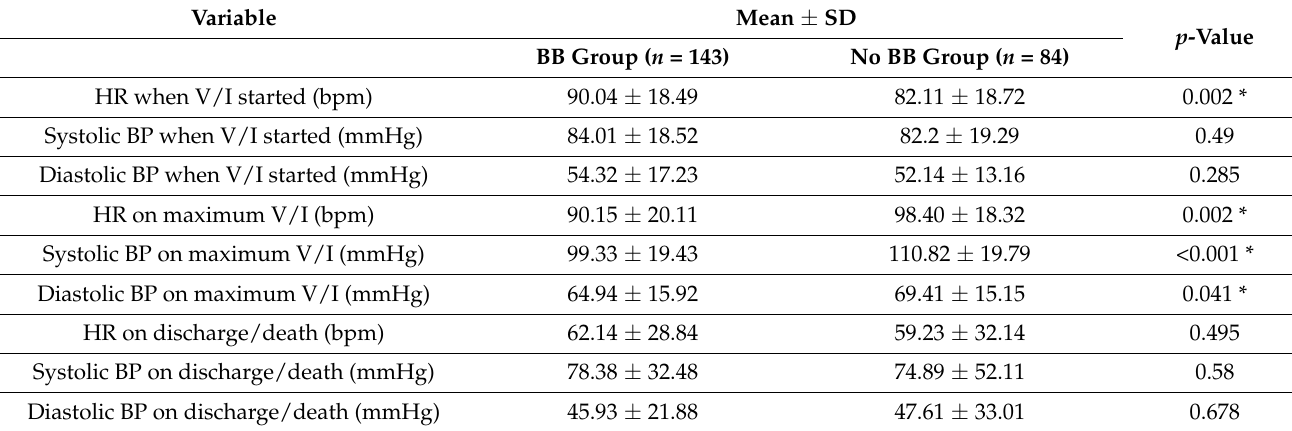
Table 2. Comparison of hemodynamic variables between BB group and no BB group.